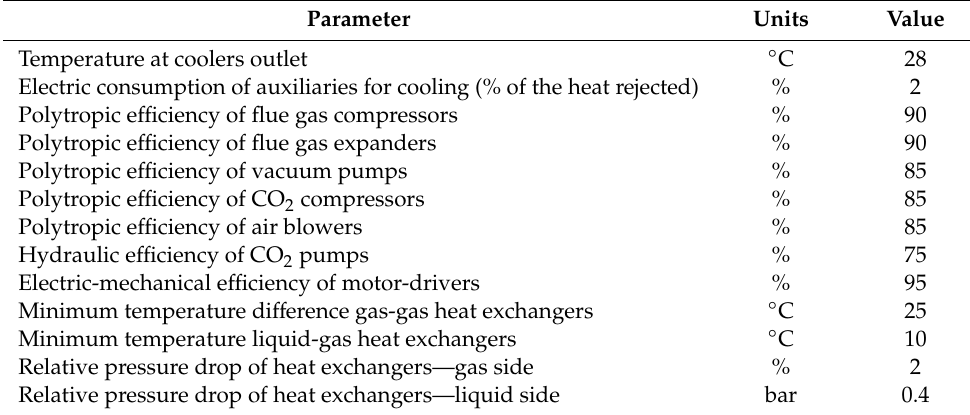
Table 4. Key assumptions for the evaluation of novel capture